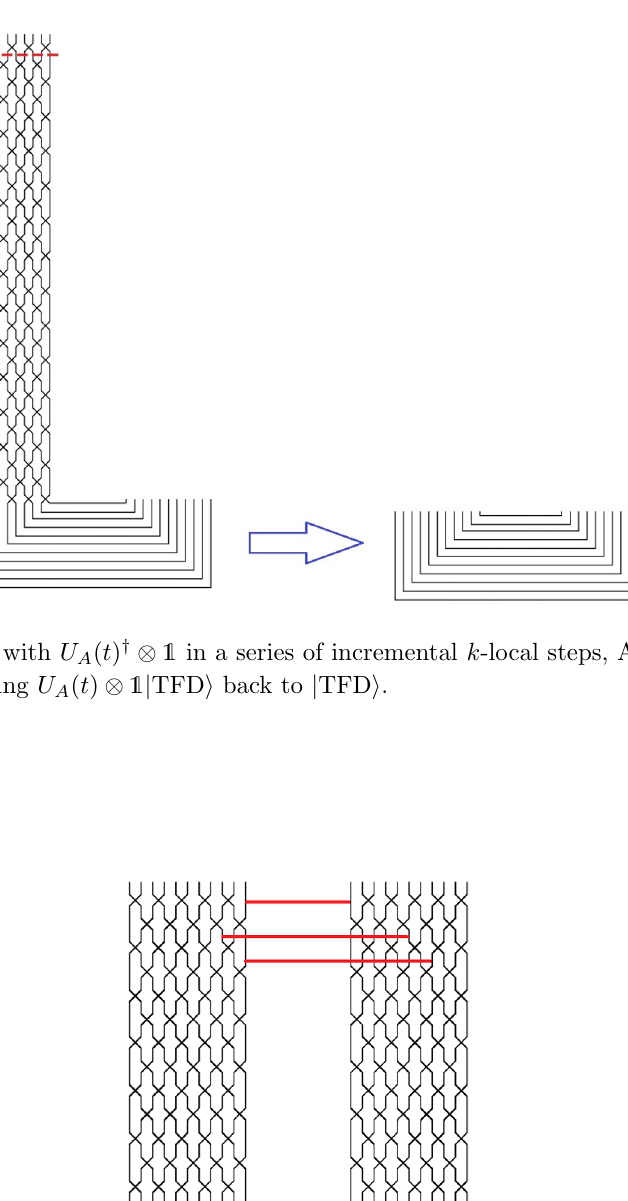
Figure 5 . A unitary U AB cannot in general be decomposed as U A (cid:10) U B . In the example in this (cid:12)gure, the horizontal red links between the left and right sides represent gates which couple qubits on the two sides.